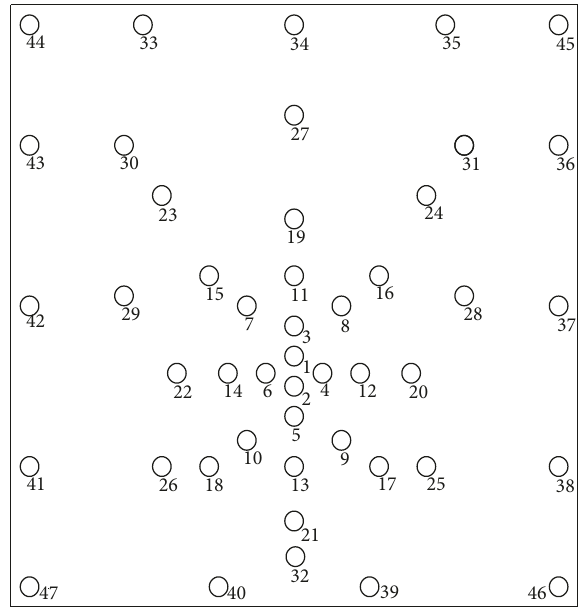
Figure 6: Four-hole blasting scheme (the numbers in the figure represent the hole number). Table 2: Explosion parameters of the four-hole slotting scheme.